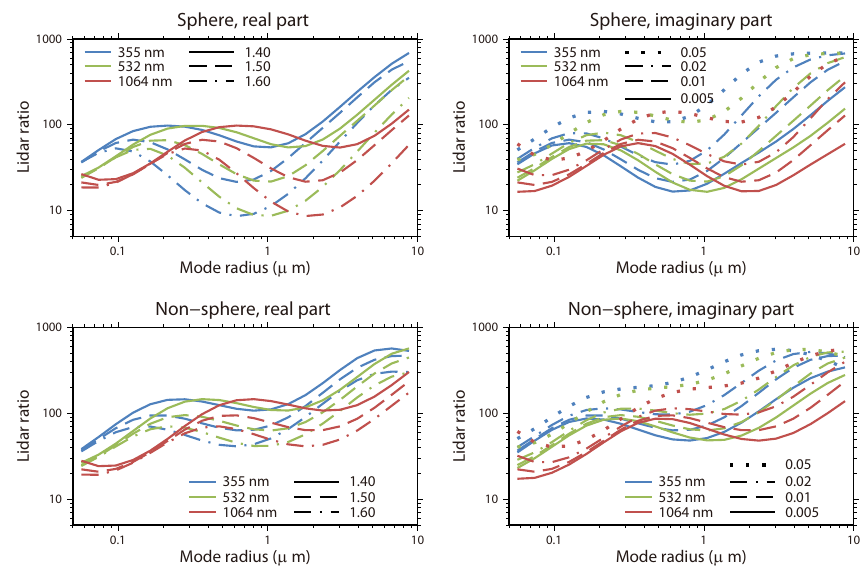
Figure 16. Lidar ratio as a function of the mode radius of the mono-modal lognormal size distribution. The mode width is fixed by 0.5. The imaginary part of the refractive index is 0.01 in the left panels. The real part of the refractive index is 1.50 in the right panels.